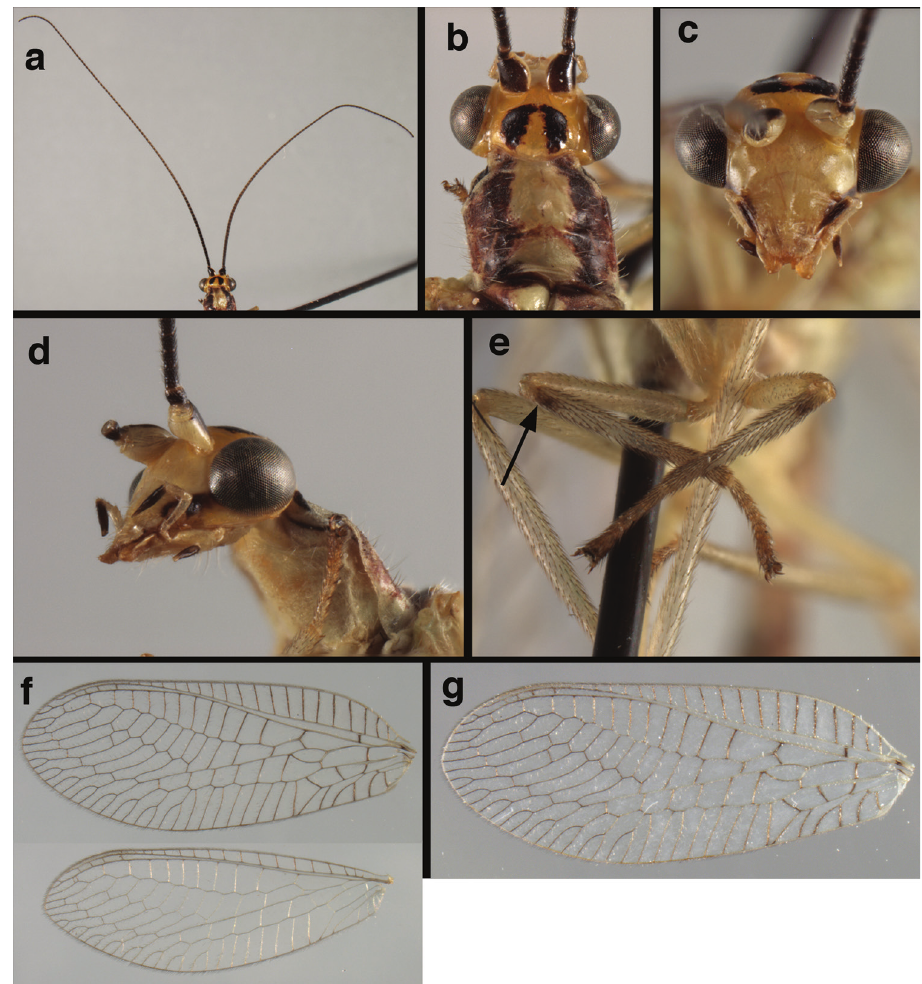
Figure 16. Ungla banksi Tauber, new replacement name: External features, ( a ) head, antennae, dorsal ( b ) head, prothorax, dorsal ( c ) head, frontal ( d ) head, prothorax, lateral ( e ) forelegs, frontal [arrow indicates foretibial mark.] ( f ) wings, venation emphasized ( g ) forewing, coloration of veins emphasized (Bolivia, La Paz, female,